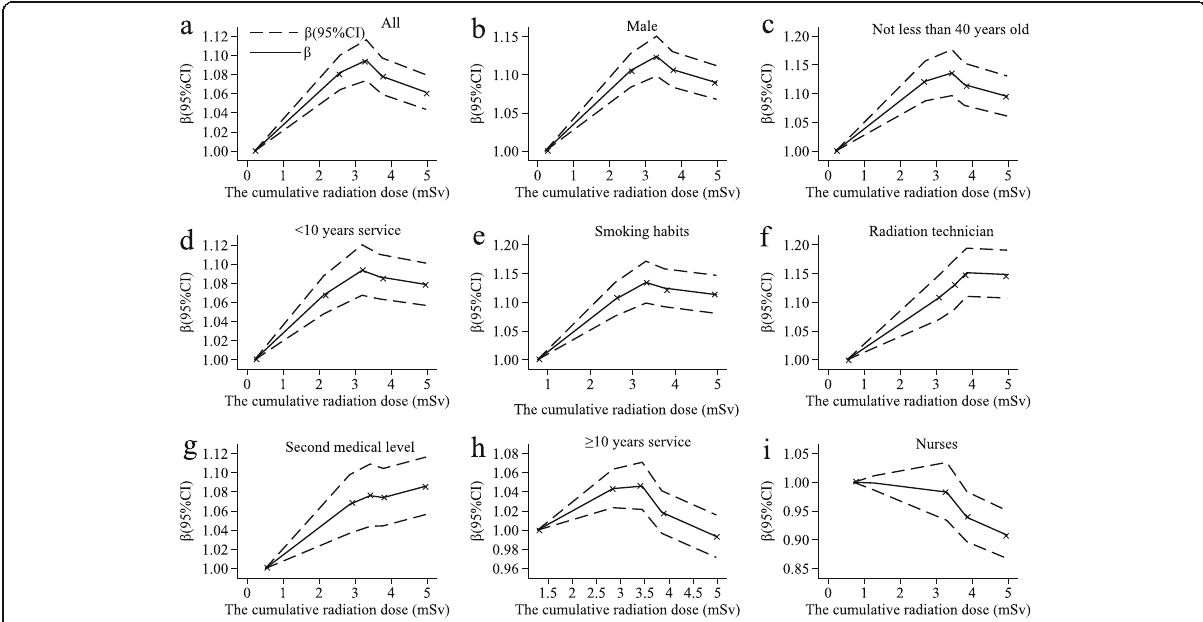
Fig. 1 The dose-response relationship between platelets changing and the cumulative radiation dose. We recorded the changes of platelets in a the whole population, b male, c not less than 40 years old, d less than 10 years of service, e smoking habits, f radiation technician, g second medical level, h over 10 years of service, and i nurses occupations. The solid and dashed lines are β values and corresponding 95% confidence intervals. β coefficients were estimated using Poisson